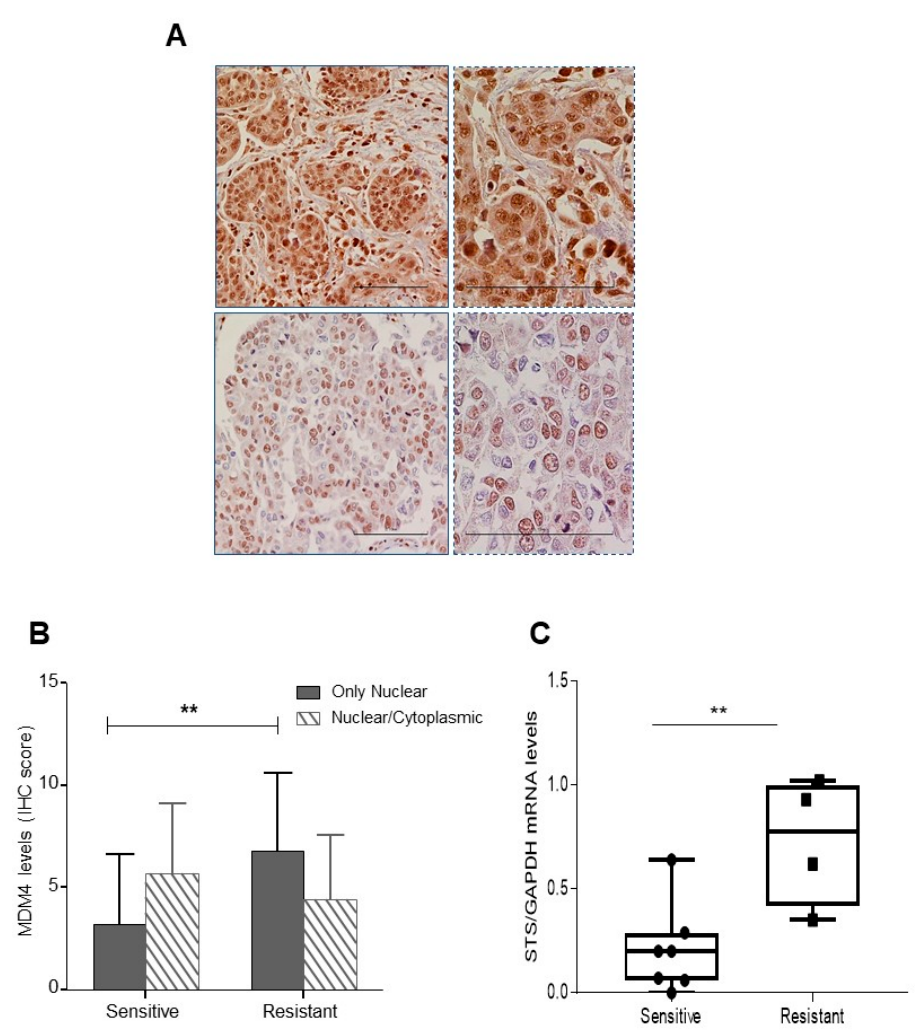
Figure 5. Nuclear MDM4 signal is increased in chemo-resistant high-grade serous ovarian cancer (HGSOC). ( A ) Representative pictures of MDM4 showing nuclear/cytoplasmic (upper panel) and only nuclear (lower panel) signal in HGSOC, irrespective of their IRS score. Right panels represent magnification of left panels (Scale bar, 100 µm). ( B ) MDM4 levels (mean ± SD, IHC = immunoreactive score) in nuclear and nuclear/cytoplasmic compartments of sensitive and resistant patients (** p < 0.01, two-tailed unpaired t -test, n = 33, DF = 31, t = 2.773, ** p = 0.0093). ( C ), qPCR of STS mRNA extracted from available matched frozen samples examined in B (mean ± SD, two-tailed unpaired t -test, n = 11, DF = 9, t = 3.34, ** p = 0.0087).